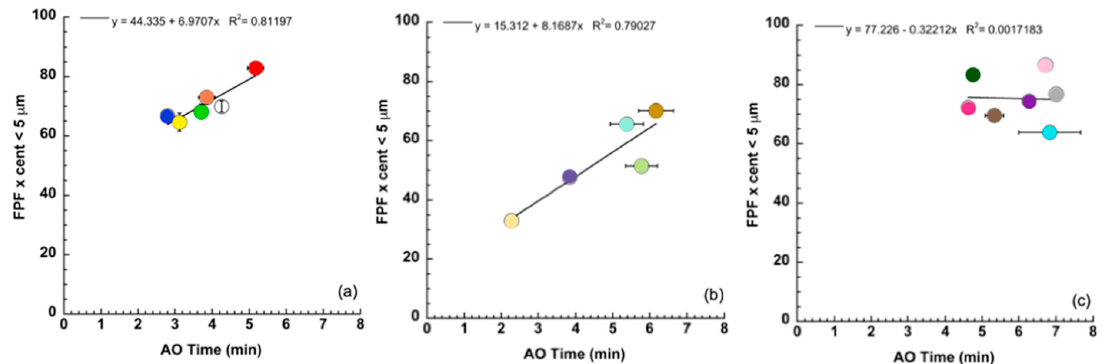
Figure 3. FPFs for the jet nebulizers manufactured by Pari ( a ), Omron ( b ), and Flaem ( c ) versus the